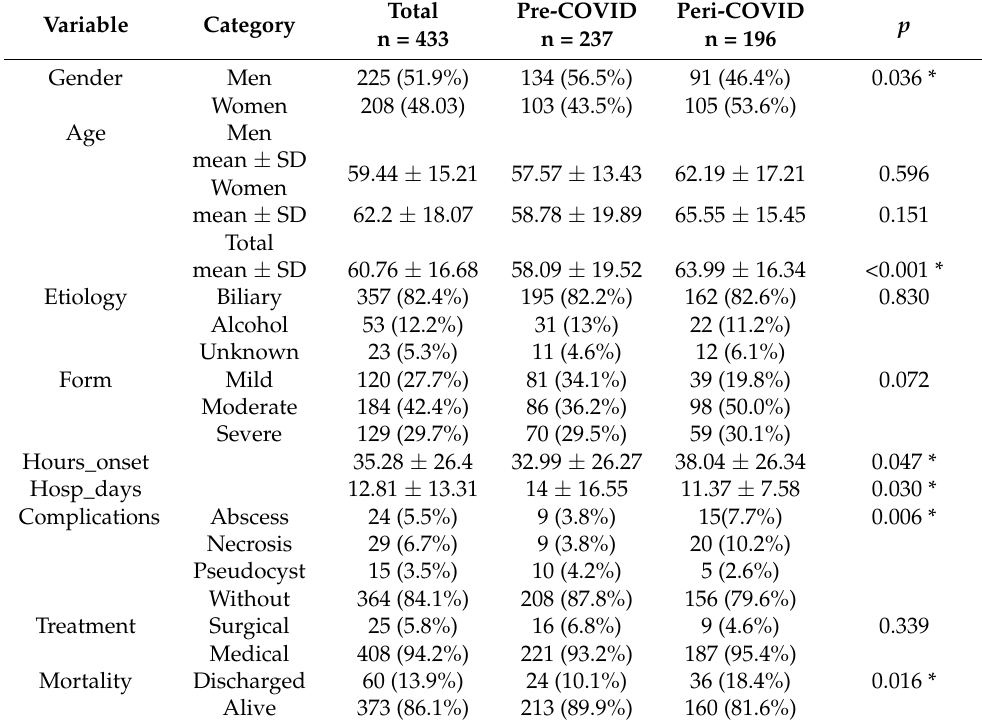
Table 2. Demographic characteristics of pre-COVID peri-COVID